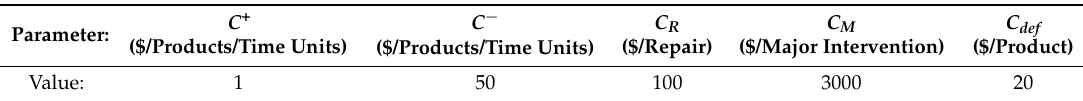
Table 2. Cost parameters for the numerical example.